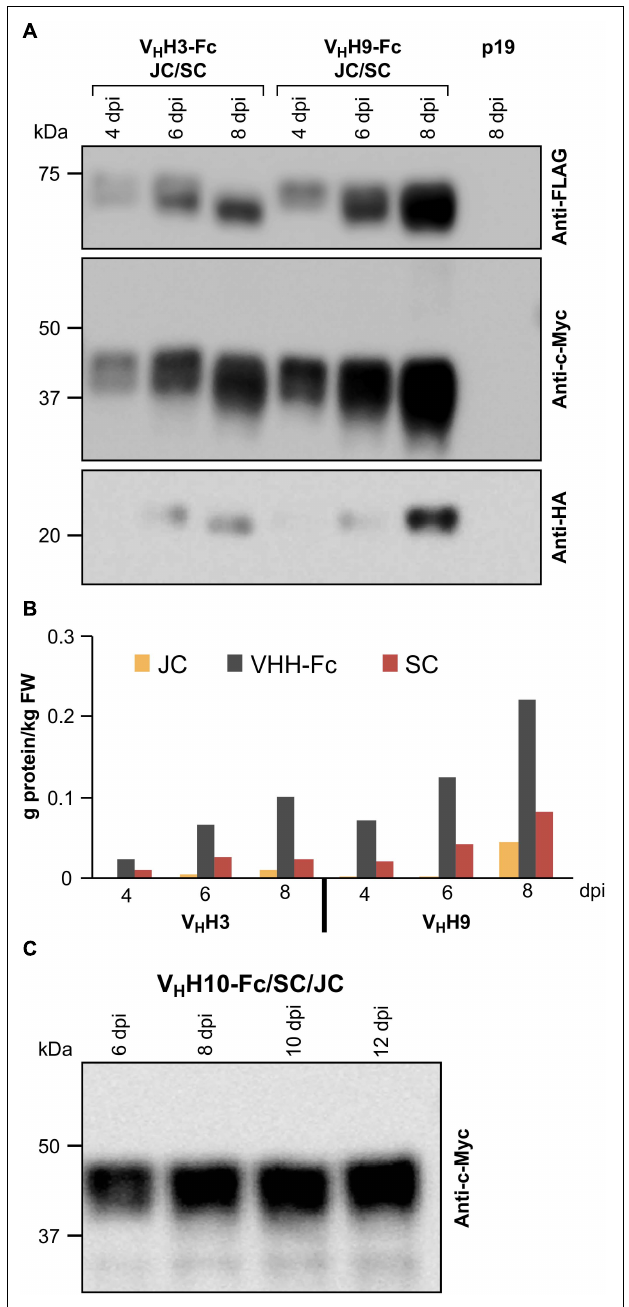
FIGURE 2 | Optimization of the accumulation levels of V H H-sIgA subunits after transient transformation of N. benthamiana leaves. (A) N. benthamiana leaf tissue was infiltrated with Agrobacterium mixtures containing the following ODs ( A 600 ); V H H-Fc: 0.57, SC: 0.14, JC: 0.14, and p19: 0.14. Leaf tissue was collected 4–8 dpi. TSP was extracted from pooled samples from three independent biological replicates. Ten micrograms of TSP was loaded in each well, separated by SDS-PAGE under reducing conditions, and visualized by western blot. Known amounts of c-Myc, HA, and FLAG tagged protein were used as reference (not shown). TSP from p19-infiltrated N. benthamiana leaves was used as a negative control. (B) Quantification of (A) by densitometry. (C) Time-course (6–12 dpi) of V H H10-Fc accumulation in combination with SC and